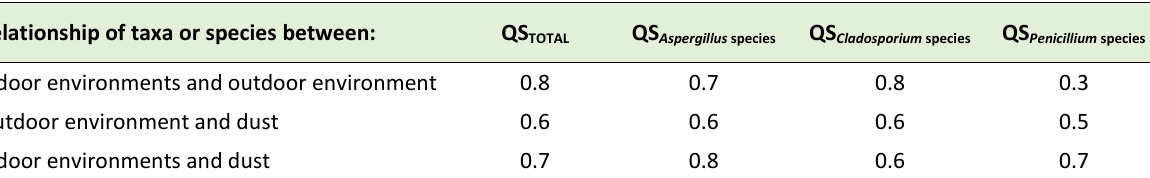
TABLE 5. Sørensen's coefficient of similarity (QS) obtained by comparing the total number of taxa and species belonging to Aspergillus , Cladosporium and Penicillium genera isolated in the three studied niches. Relationship of taxa or species